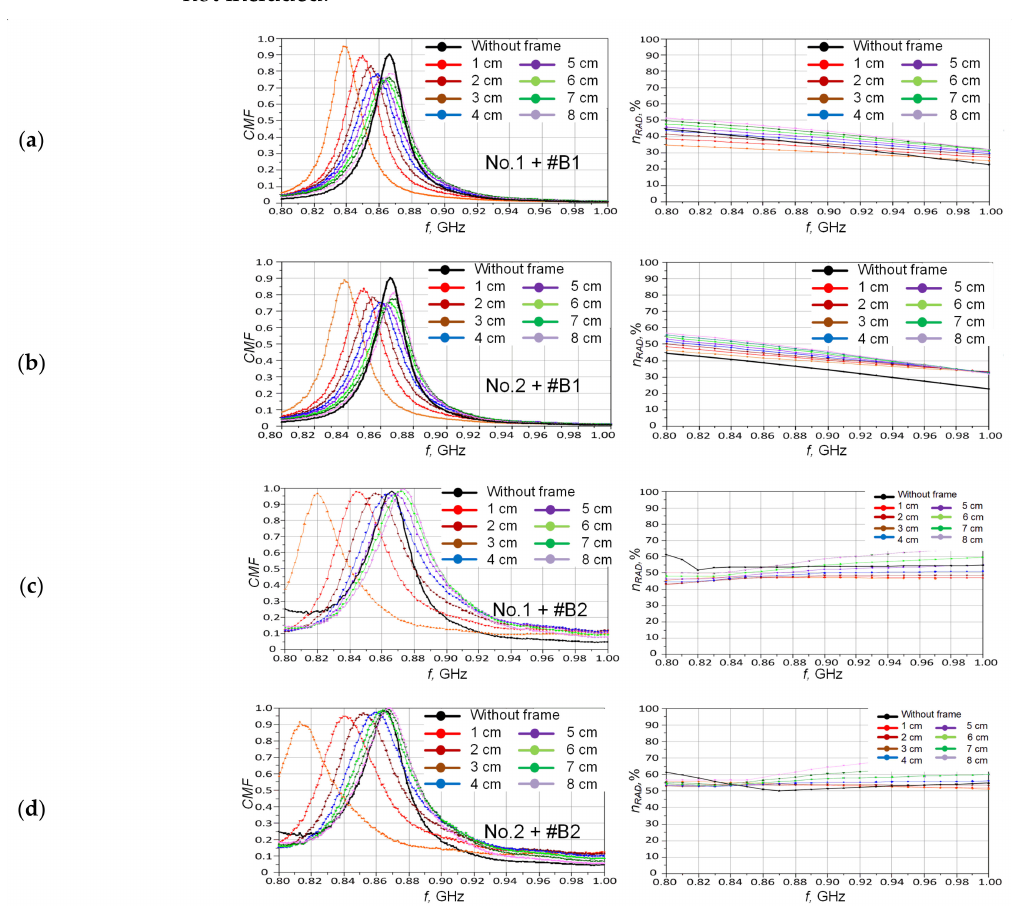
Figure 19. CMF and radiation efficiency n RAD vs. separation distance between unit frame and antenna radiator in arrangements: ( a ) No.1+#B1; ( b ) No.2+#B1; ( c ) No.1+#B2; ( d )